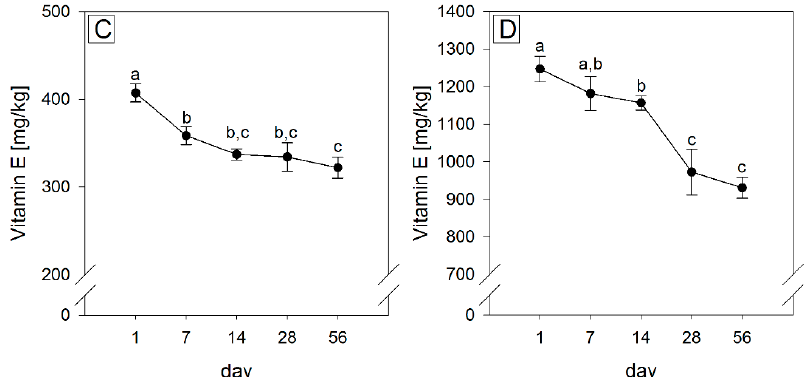
Figure 1. Changes of the total tocopherol contents in different oil types ( A ) sunflower oil; ( B ) canola oil; ( C ) soybean oil and ( D ) fortified soybean oil stored at 22 °C in a 12 h light/dark cycle for 56 days. Data are represented as mean ± SD ( n = 4). Statistically significant differences were analyzed using one-way ANOVA ( p ≤ 0.001) followed by Holm-Sidak post hoc test ( p < 0.05). Different letters indicate significant differences.